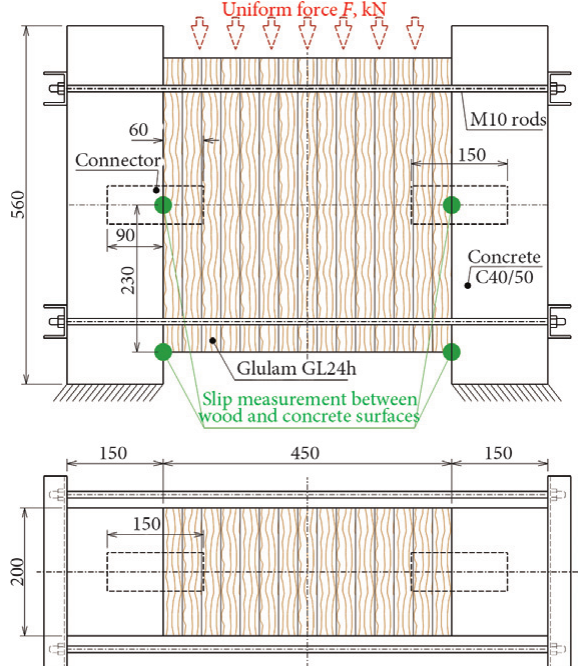
Fig. 5. Elevation and top view of the test setup